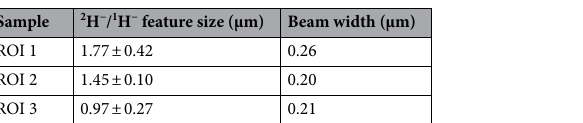
Figure 1. Secondary electron, 1 H − , 2 H − images and the 2 H − / 1 H − ratio for three separate regions of interest (ROIs) showing the total counts summed over 10 image planes for ROIs 1 & 2 and 5 image planes for ROI 3. ROIs 1 and 2 are from the Zy-4 sample and ROI 3 is from the 48.3 day Zy-2 sample. ROIs 1 and 2 were implanted with 5.7 × 10 17 ions/cm 2 prior to imaging and imaged with currents of 1.79 pA and 1.75 pA respectively, a dwell time of 5000 μs/pixel and 256 × 256 pixels over a 30 μm raster size. ROI 3 was implanted with 3 × 10 17 ions/cm 2 prior to imaging and imaged with a current of 1.57 pA, a dwell time of 5000 μs/pixel and 256 × 256 pixels over a 30 μm raster size.